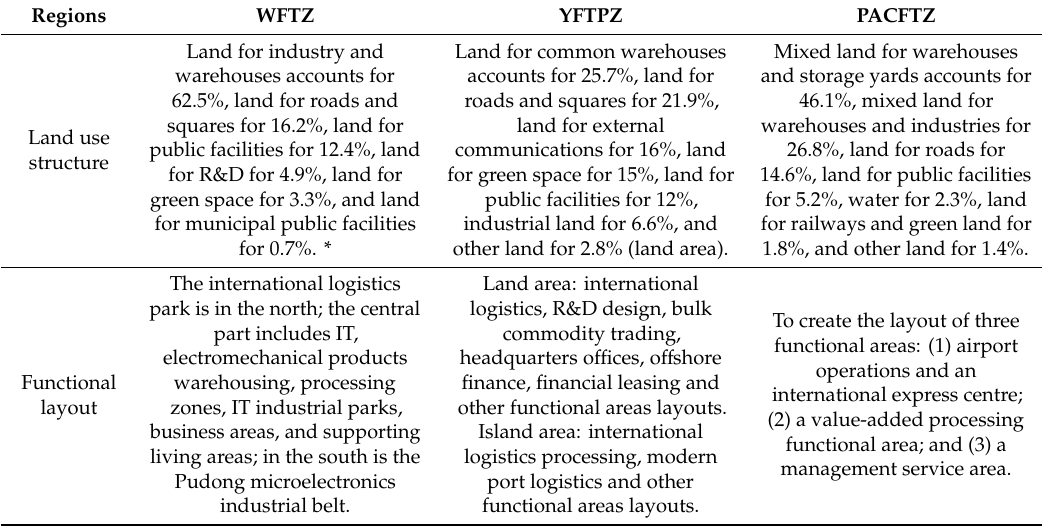
Table 8. Land use structure and functional layout in the SPFTZ